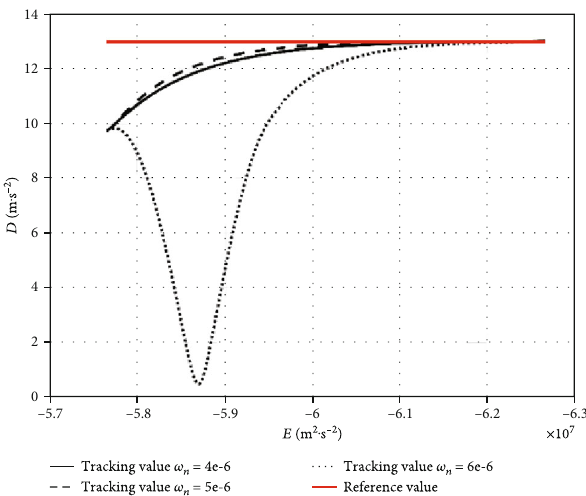
Figure 2: Drag acceleration command tracking process with ω 5 e − 6 .